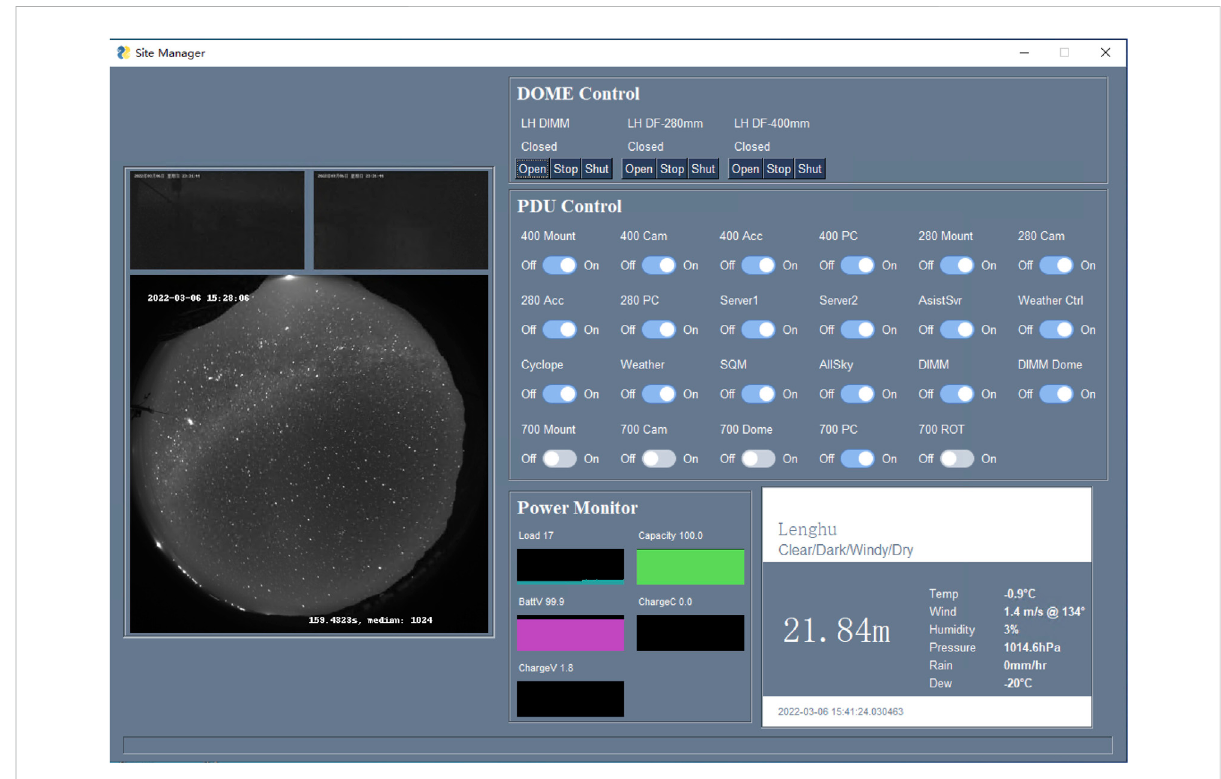
CHES site manager UI was used to show the webcam, all sky cam, solar power and weather, and to control the dome and power distribution unit. Each part of this UI is shown only if the related device is presented in the con fi guration, to keep the code universal for different site as much as possible. The similar UI is implemented in the Django website and communicate with this manager via websocket.